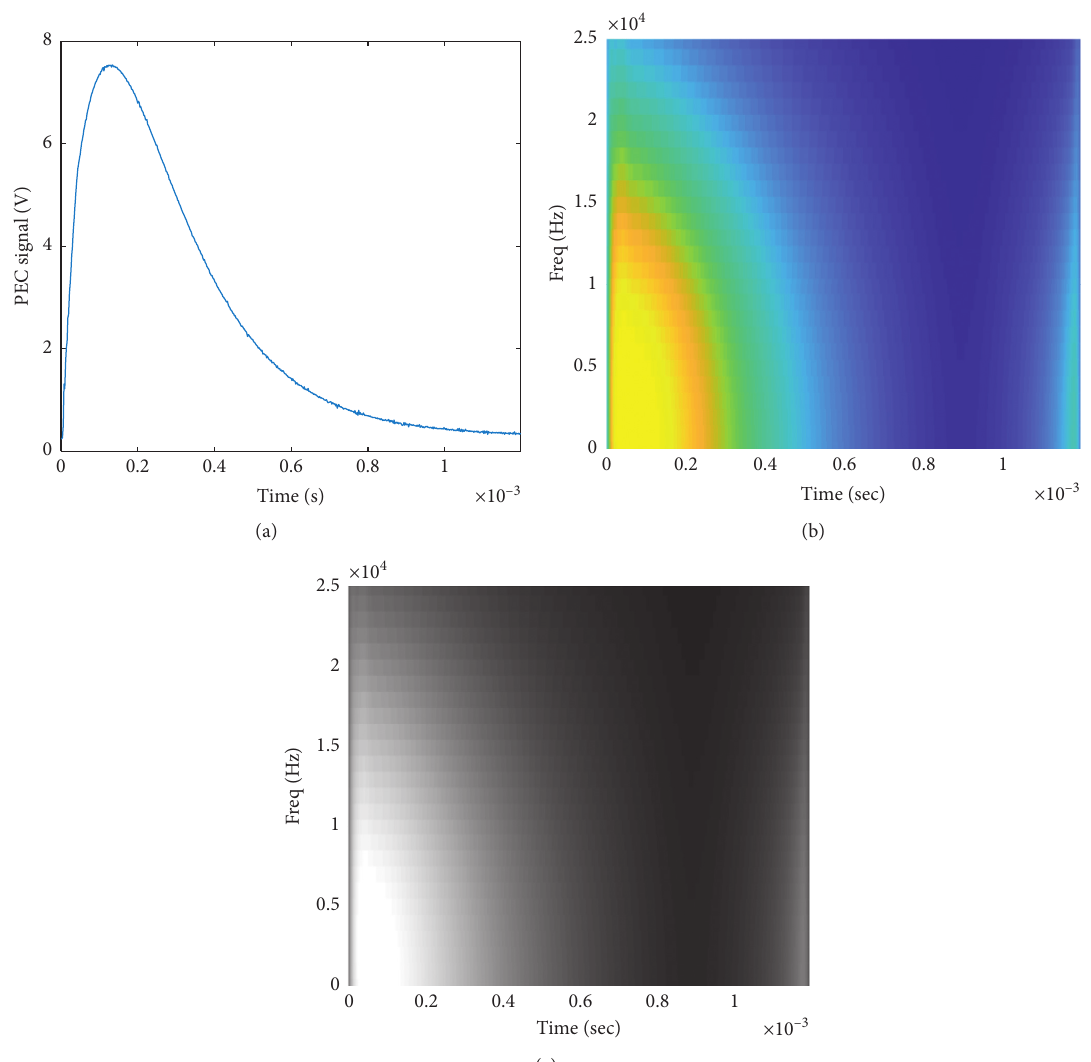
Figure 4: TFR obtained using the GWT method: (a) PEC signal; (b) TFR; (c) gray